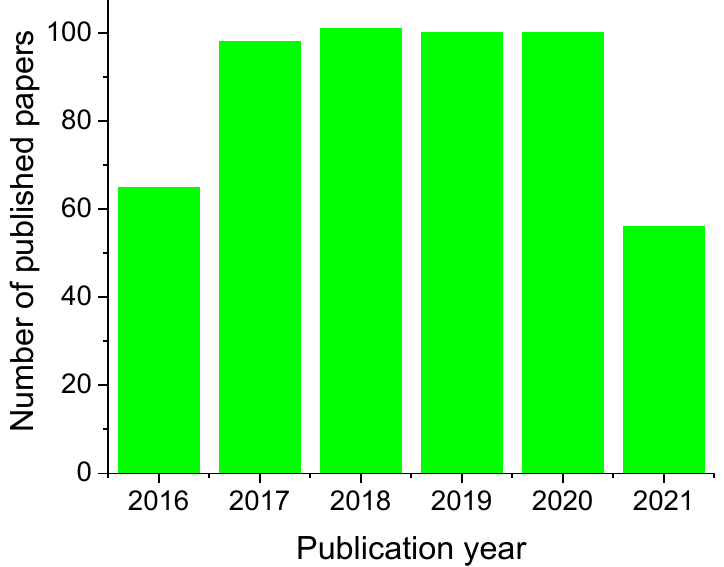
Figure 1. Number of publications per year in the English language. (SciFinder Search with keywords: immobilized enzymes + magnetic nanoparticles on 28 July 2021).